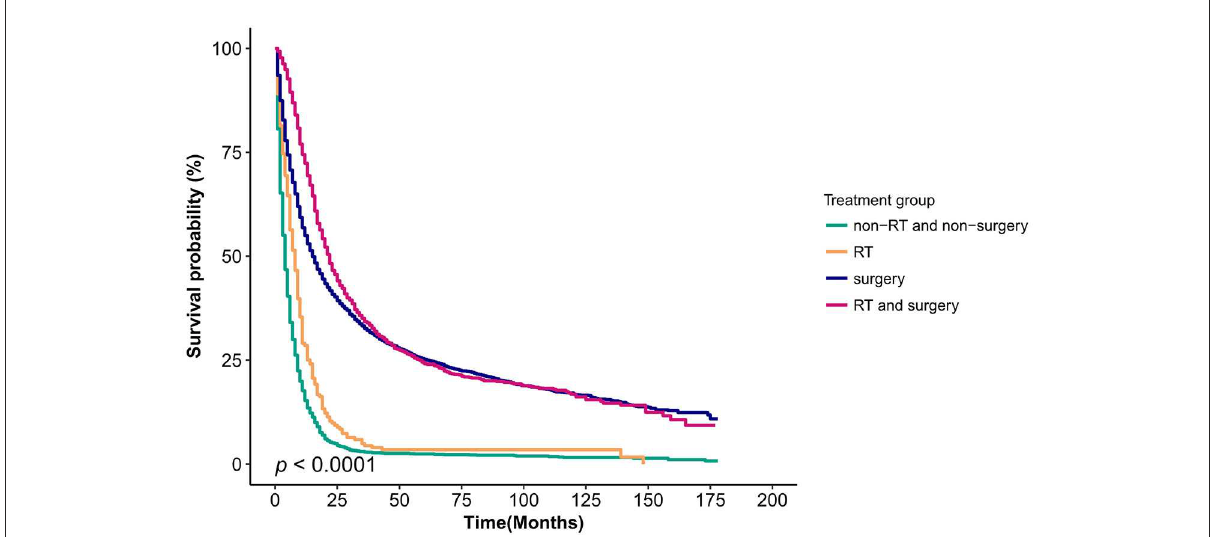
FIGURE2 Kaplan–Meier survival curves for the four treatment category groups (non-RT and non-surgery, RT and surgery, RT, and surgery) for patients with gallbladder cancer. RT, radiotherapy.